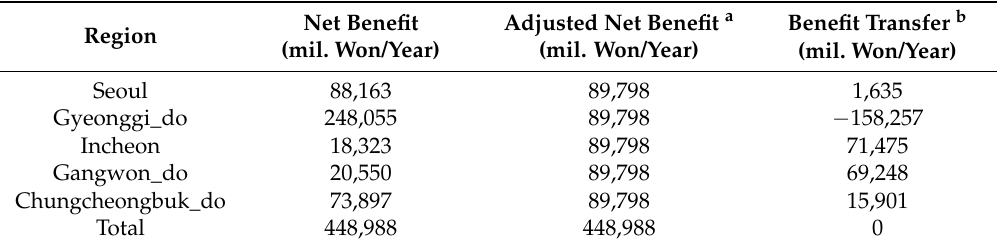
Table 8. Equal distribution of net benefits and amount of benefit